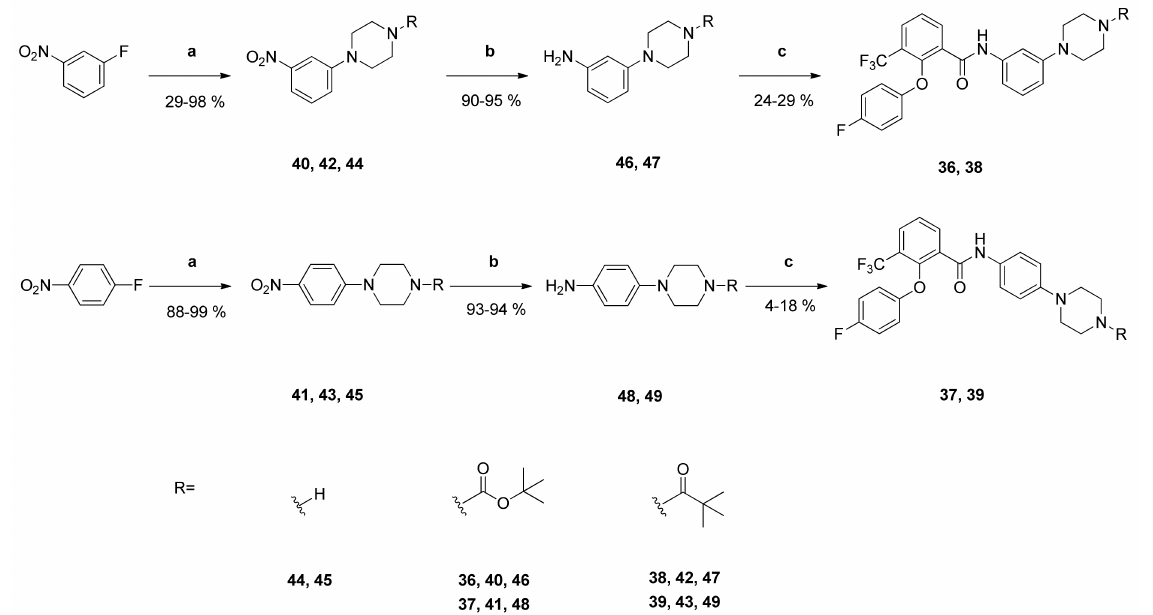
Figure 5. Preparation of compounds 36 – 39 . Reagents and conditions: ( a ) (1) N - Boc -piperazine, K 2 CO 3 , DMSO, 120 ◦ C, 120 h (compound 40 ) or N - Boc -piperazine, K 2 CO 3 , DMSO, 80 ◦ C, 72 h (compound 41 ); (2) trifluoroacetic acid, CH 2 Cl 2 , rt, 24 h (compounds 44 and 45 ); (3) pivaloyl chloride, triethylamine, CH 2 Cl 2 , rt, 24 h (compounds 42 and 43 ); ( b ) 15% (m/m) palladium on activated carbon, H 2 , Me OH, rt, 24 h; ( c ) (1) carboxylic acid 2 , CH 2 Cl 2 , 0 ◦ C, 5 min; (2) 2-chloro- N - methylpyridinium iodide, DIPEA, rt, 24 h.